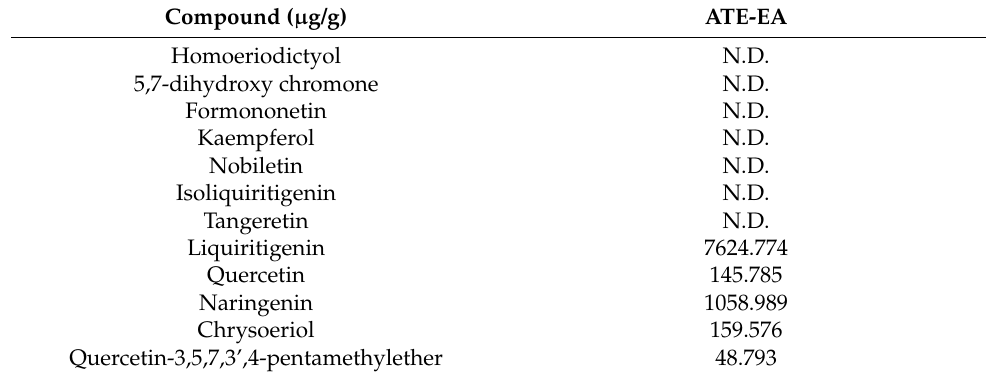
Table 2. Detection and quantification of the flavonoid compounds from ATE-EA by HPLC.